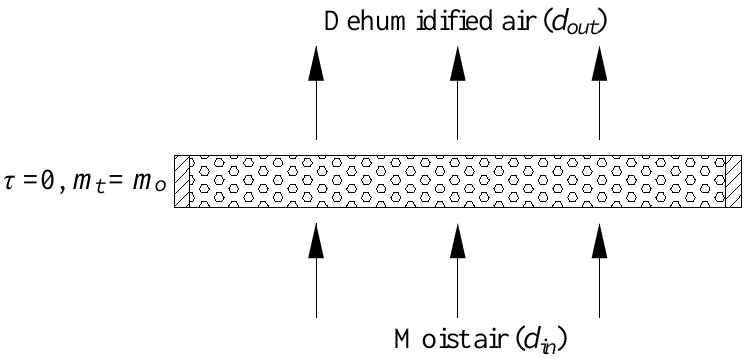
Figure 12. The mass transfer process for the proposed solid desiccant module.